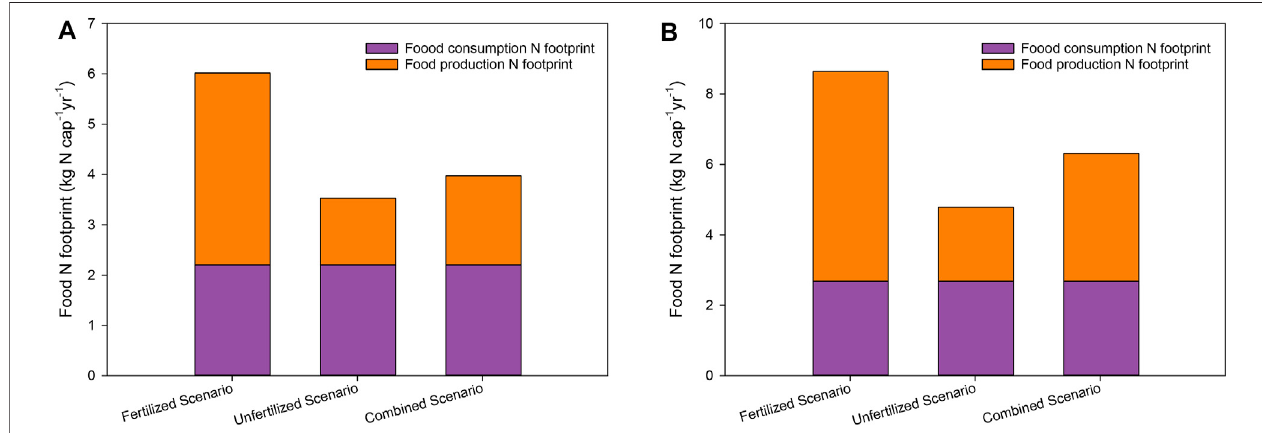
FIGURE 7 | Food N footprint under different scenarios in the 1960s (A) , and during 2010 – 2018 (B) .